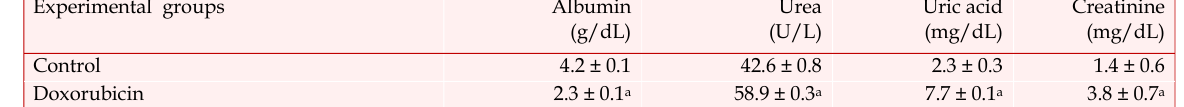
Serum markers of kidney function in different treatment groups Experimental